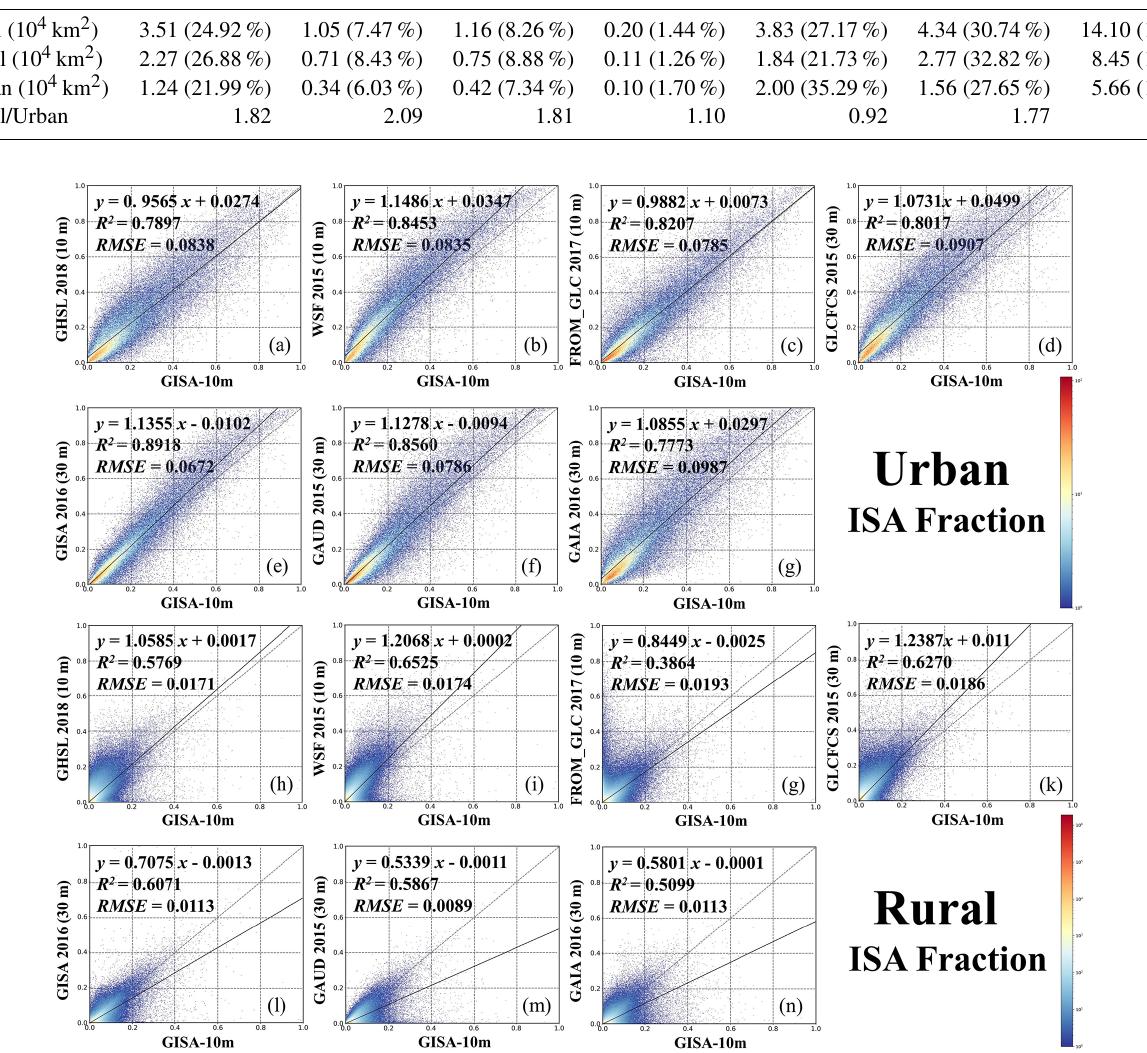
Figure 9. Scatterplots of the urban and rural ISA fraction between GISA-10m with GHSL, WSF, FROM_GLC10, GLCFCS, GAUD, GAIA, and GISA, respectively. The ISA fraction was calculated within a 0.05 ◦ × 0.05 ◦ spatial grid.